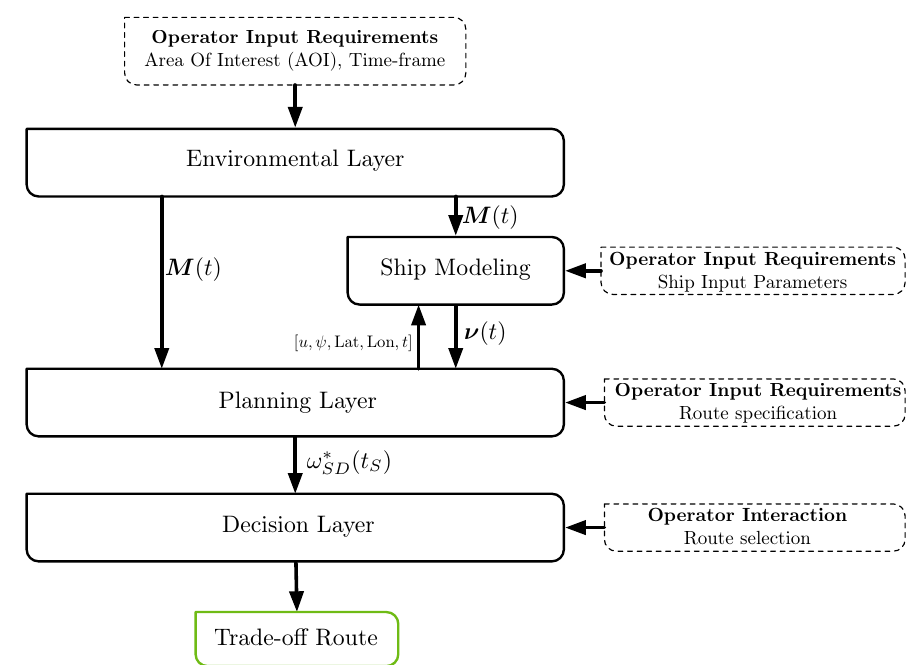
Figure 1. Underlying common architecture characterizing most of the available weather-routing